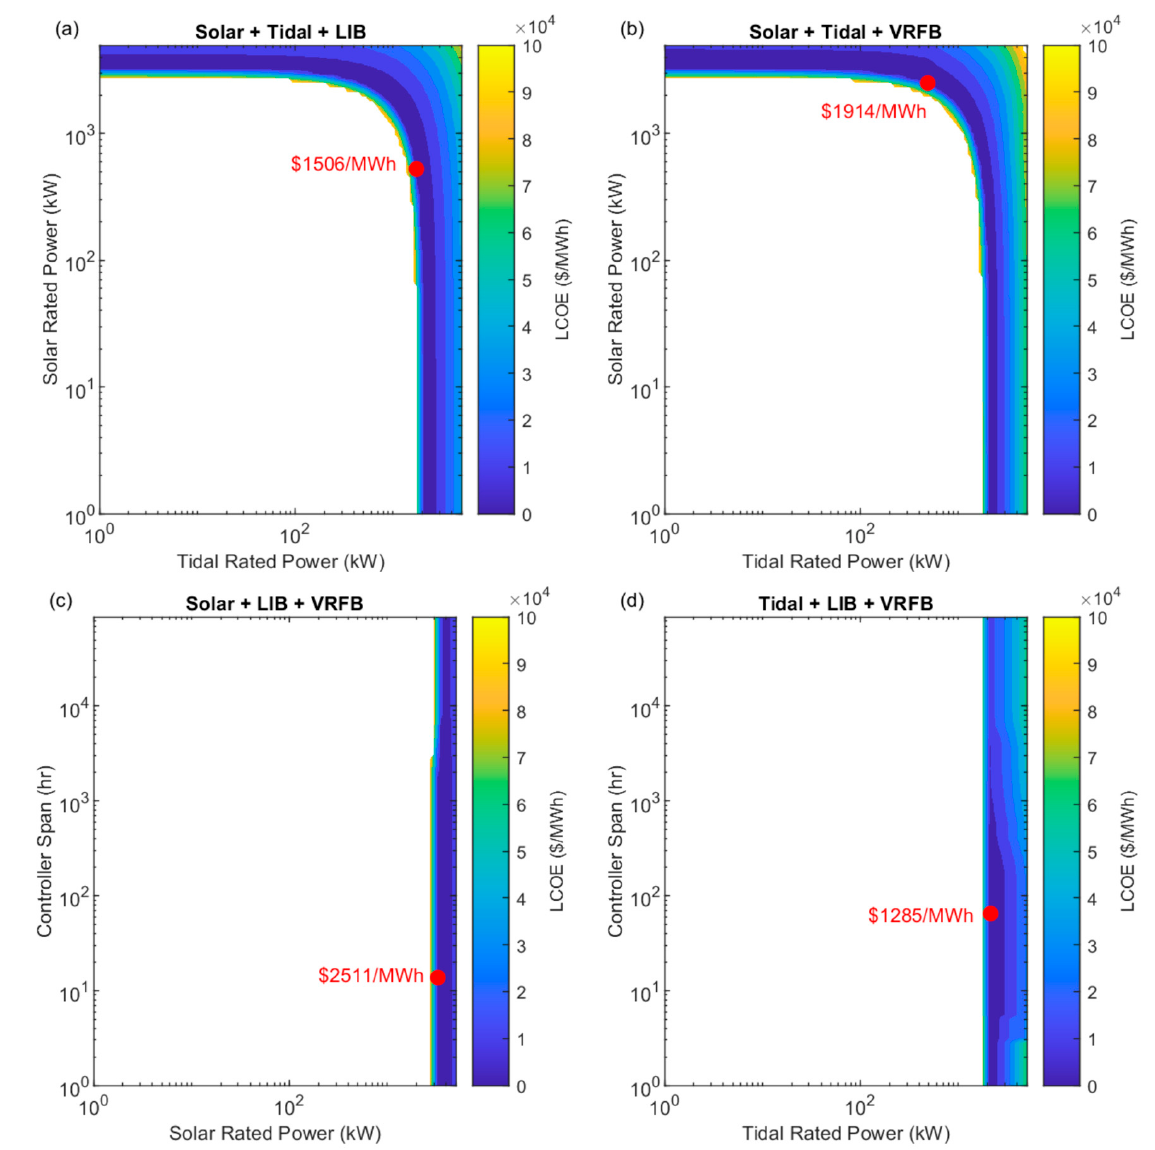
Figure 3. Grid search results plotted as LCOE contours. The red dot shows the lowest LCOE on the surface. Higher LCOEs are shown as yellow, and lower LCOE costs are shown as blue. All points on the grid with an LCOE greater than USD 100/kWh are white. Subplots ( a , b ) show the impact of solar RES rated power and tidal RES rated power on the LCOE of a system with only an LIB ESS and VRFB ESS, respectively. Subplots ( c , d ) show the impact on LCOE of the span of the battery controller moving average filter and the rated power of the solar and tidal RES, respectively.